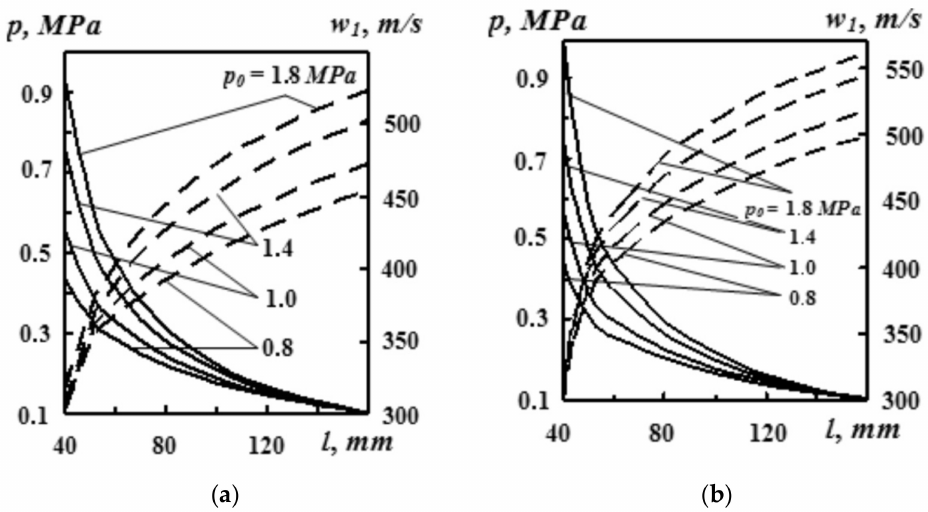
Figure 7. Pressure p 0 vs. distribution of static pressure p (—-) and gas flow rate w 1 (—) at a distance l from the broadening part of the nozzle. Source data: ( a ) µ = 1.5 kg · kg − 1 and ( b ) µ = 0.3 kg · kg − 1